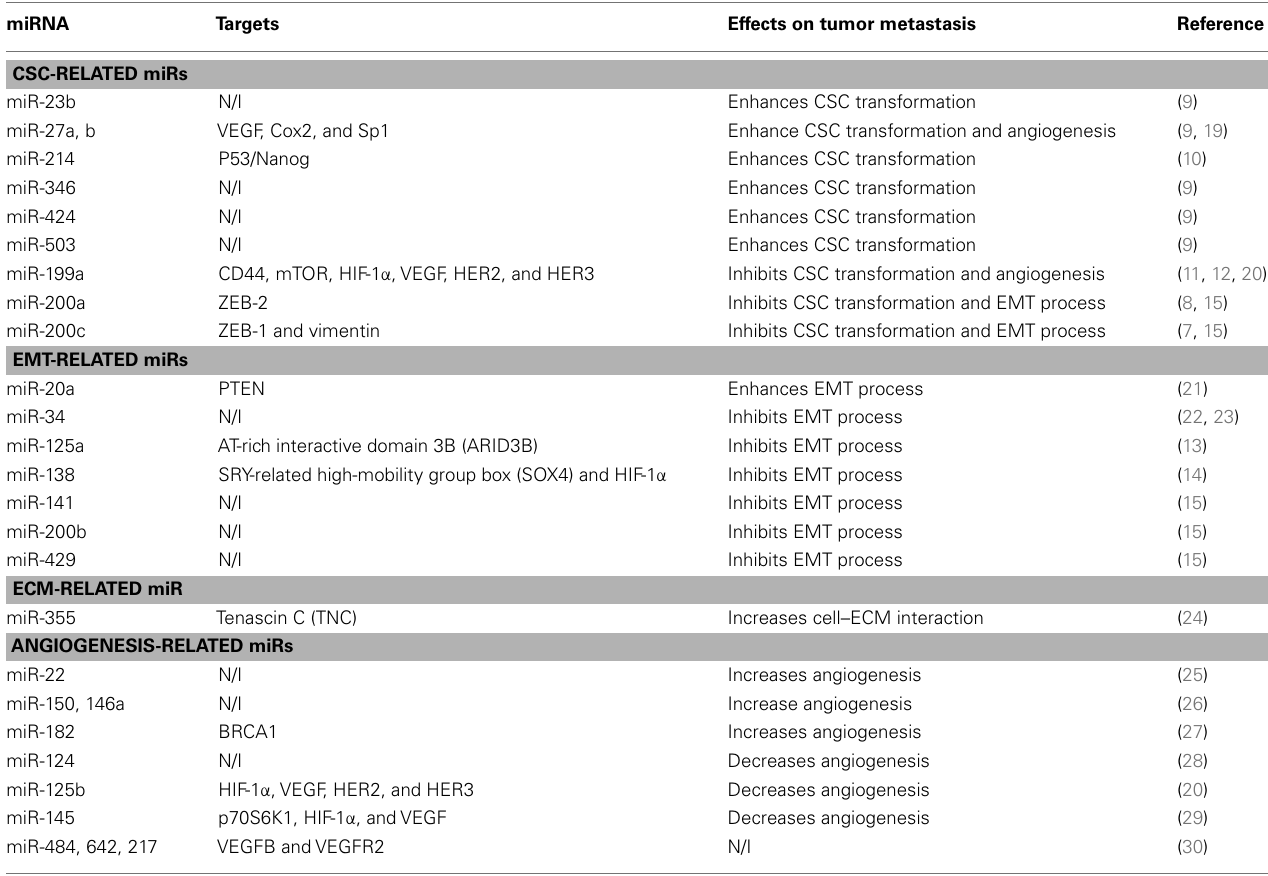
Table 1 | microRNAs aberrantly expressed in ovarian cancer and their target genes . miRNA